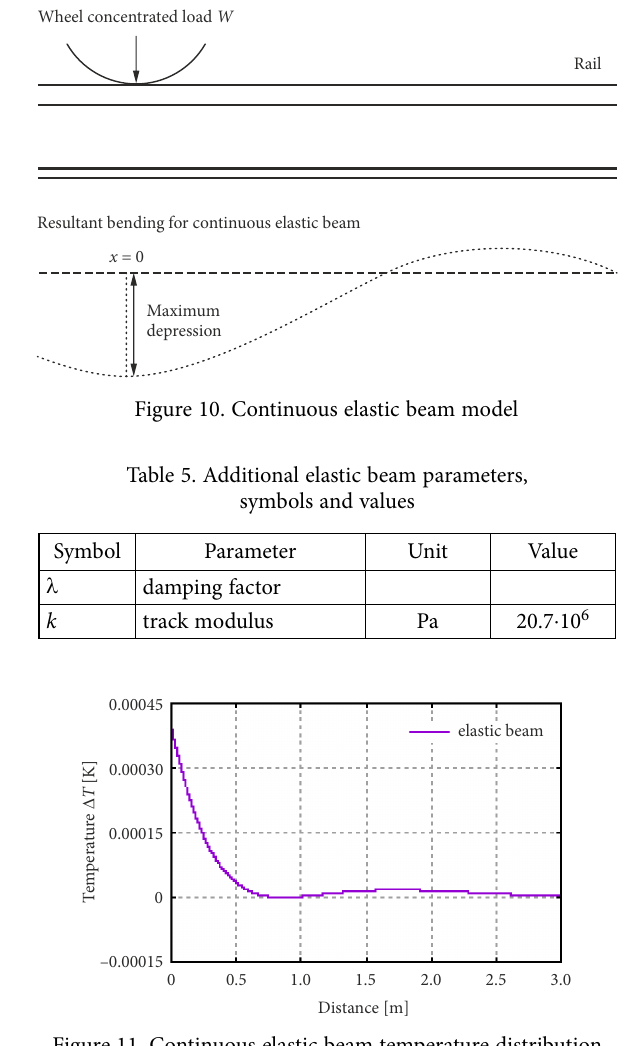
Figure 11. Continuous elastic beam temperature distribution